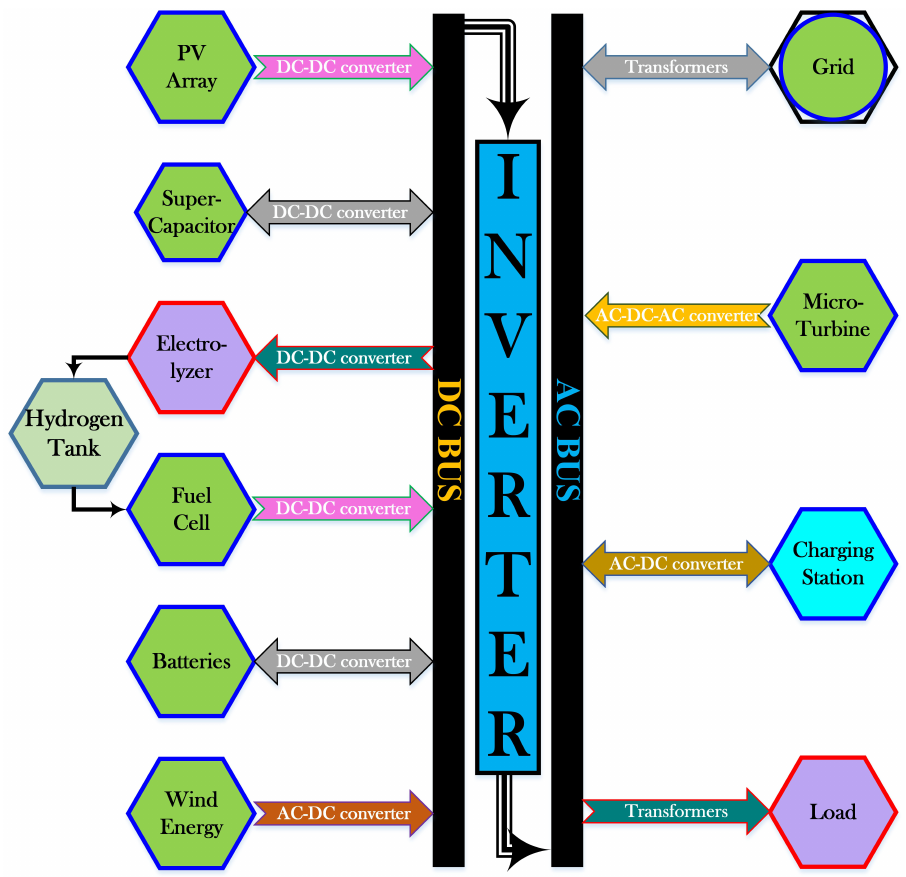
Figure 1. General sketch of the proposed